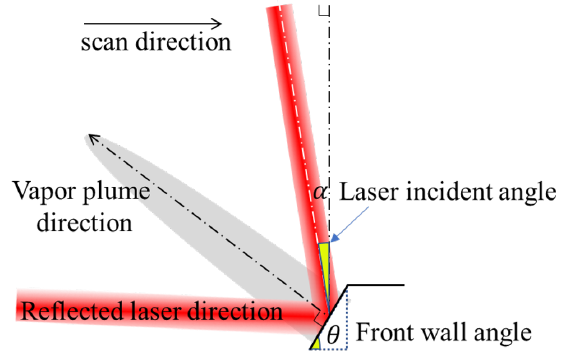
Figure 10. Schematic of laser incident angle, front wall inclination, and vapor flow